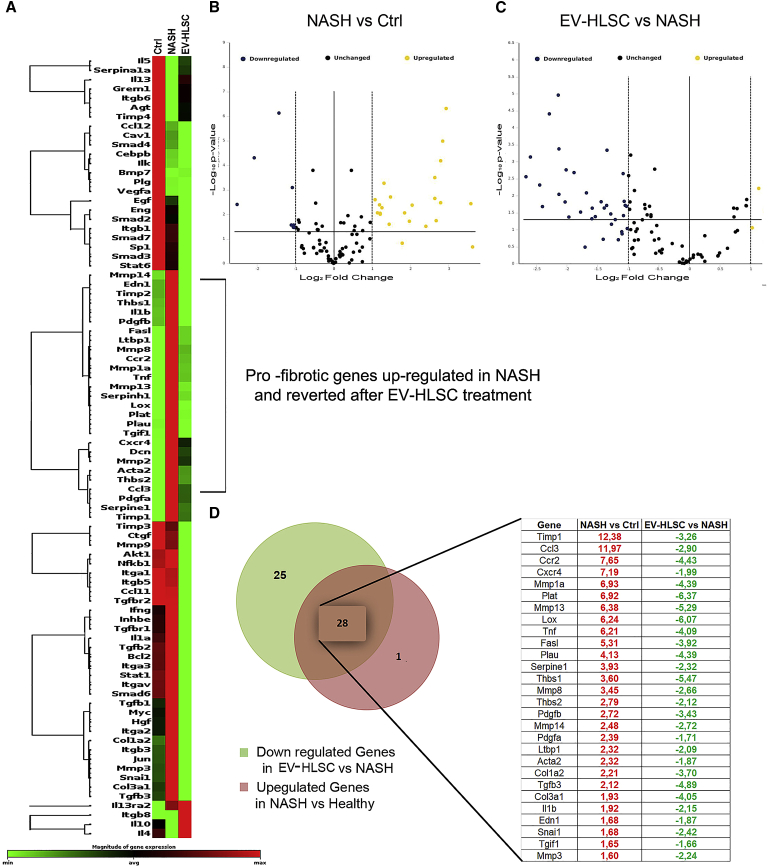
Expression of Fibrosis-Related Genes in NASH Mice Treated or Not with EV-HLSCs Analyzed through a Fibrosis RT2 Profiler PCR Array (QIAGEN)(A) Heatmap displaying hierarchical clustering of the entire dataset of expressed genes and indicating co-regulated genes across three different experimental groups: healthy (CTRL) mice, NASH mice, and EV-HLSC-treated mice. Clustering analysis showed that genes upregulated in NASH mice belong to pro-fibrotic and pro-inflammatory pathways; EV-HLSC treatment was able to restore their expression to healthy levels (n = 4 mice analyzed for each experimental condition). (B and C) The volcano plots identify significant changes in gene expression between groups: increased number of upregulated genes in NASH mice compared to healthy mice (B) and evident downregulation of gene expression in EV-HLSC-treated mice compared to the NASH group (C). The volcano plot displays the statistical significance (p < 0.005) versus fold change on the y and x axes, respectively. (D) Venn diagram and list of pro-fibrotic and pro-inflammatory genes regulated in NASH mice treated or not treated with HLSC EVs. The expression levels of genes are presented as fold regulation values (those greater than 1.6 are indicated in red, and those less than −1.6 are indicated in green) for NASH mice compared to those for controls (NASH vs Ctrl column) and for treated mice compared to those for the NASH group (EV-HLSC vs NASH column). Complete data are provided in Table S1.